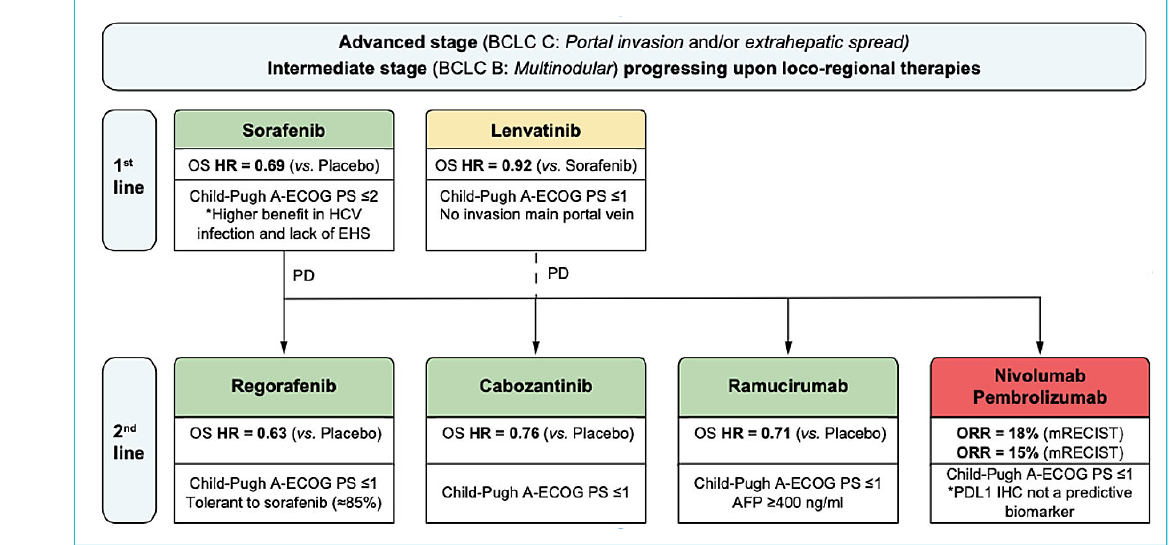
Figure 3: Treatment strategy for advanced hepatocellular carcinoma. Reproduced with permission from Llovet, Montal and Villanueva [25] . Key details of the patient populations are provided. Drugs in green have positive results from phase III trials with a superiority design, drugs in orange (lenvatinib) have positive results from phase III trials with a non-inferiority design. Drugs in red received accelerated approval by FDA based on results from phase II trials.AFP = Alpha-fetoprotein; BCLC = Barcelona Clinic Liver Cancer (classification); ECOG PS = Eastern Co- operative Oncology Group performance status; EHS = extrahepatic spread; HCV = hepatitis C virus; HR = hazard ratio; mRECIST = modified Response Evaluation Criteria In Solid Tumors; ORR = objective response rate; OS = overall